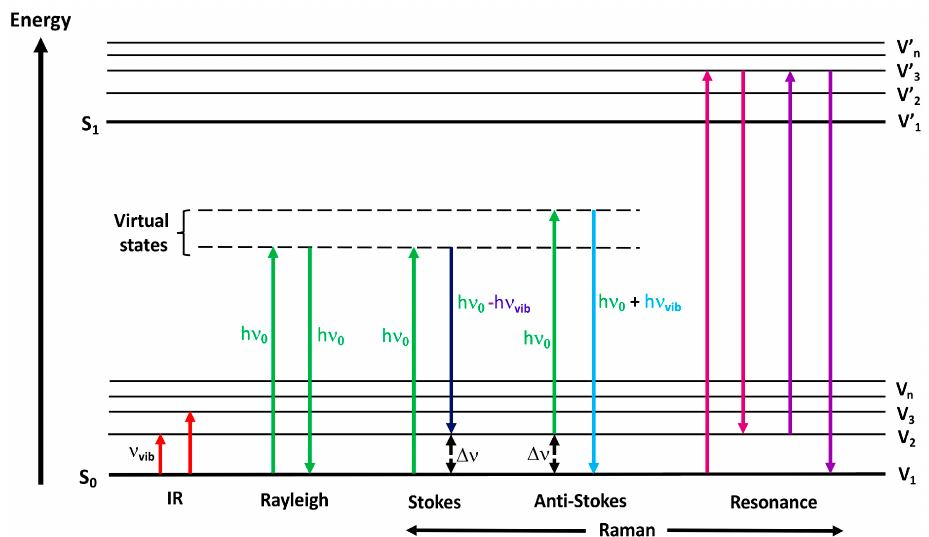
Figure 1. Jablonski energy diagram showing the transitions involved during infrared absorption, Rayleigh, Raman Stokes, anti-Stokes and Resonance Raman